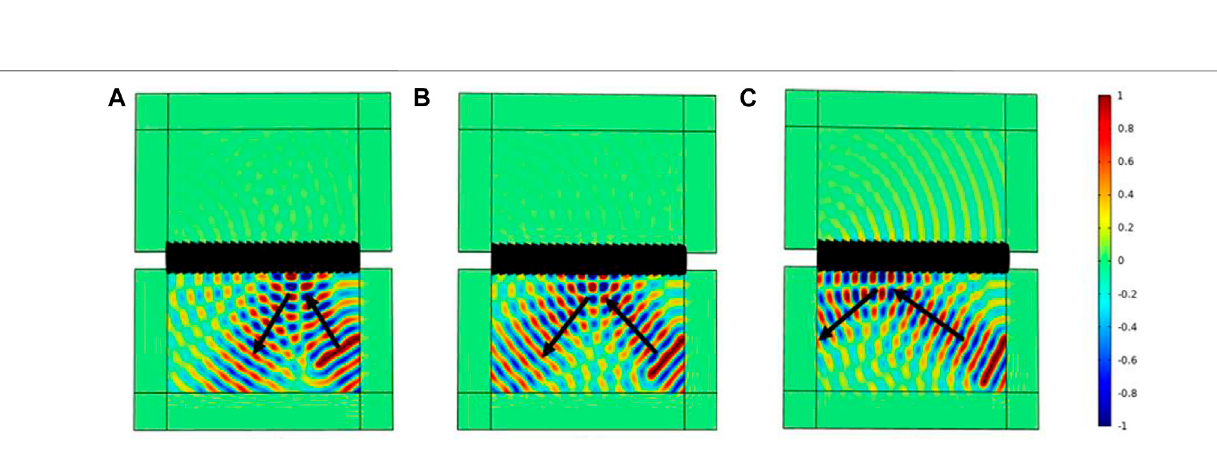
FIGURE 13 | When the number of unit cells is m = 7, the wave fi eld of the incident wave incident at different angles: (A) 30 ° ; (B) 45 ° ; (C) 60 ° .